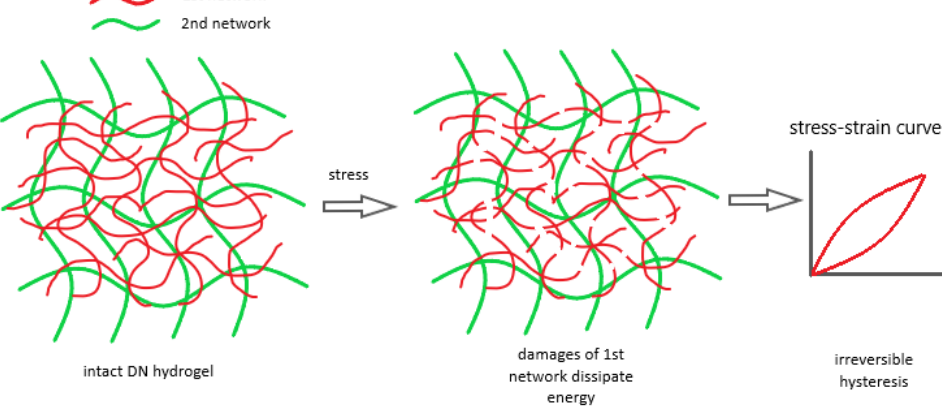
Figure 2. Damage process of DN hydrogels. The multiple damages in the 1st network dissipate large amounts of energy and lead to irreversible hysteresis in load–unload tests.